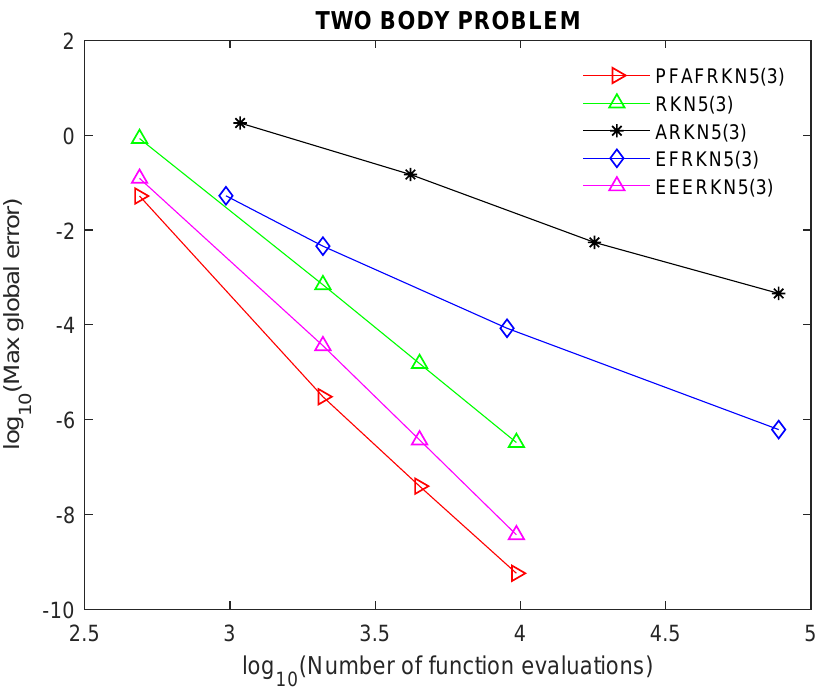
Figure 2. Efficiency curves corresponding to Problem 2.